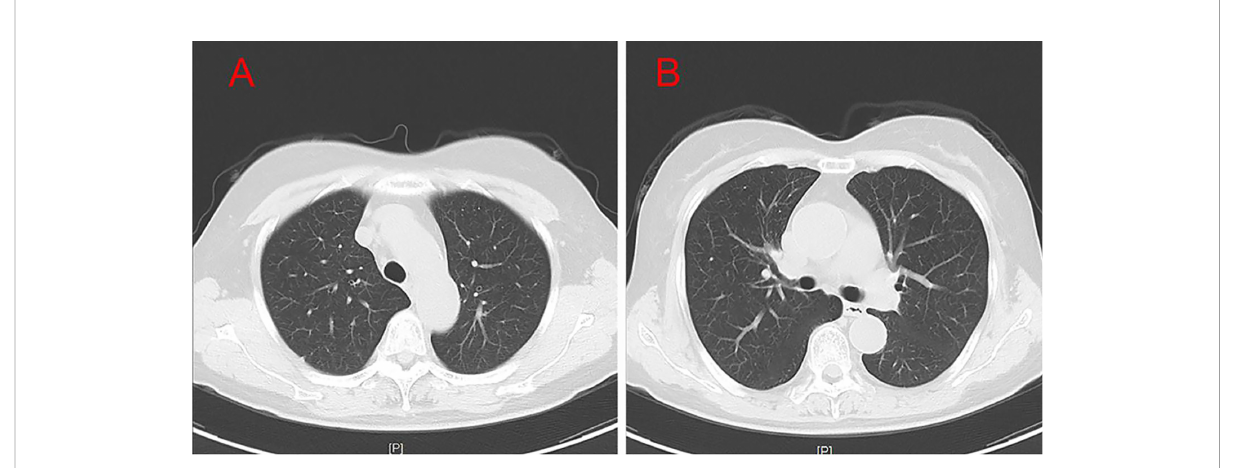
FIGURE 1 Test results of CT (A, B) . Chest CT results showed that the patient had bronchitis and multiple lung